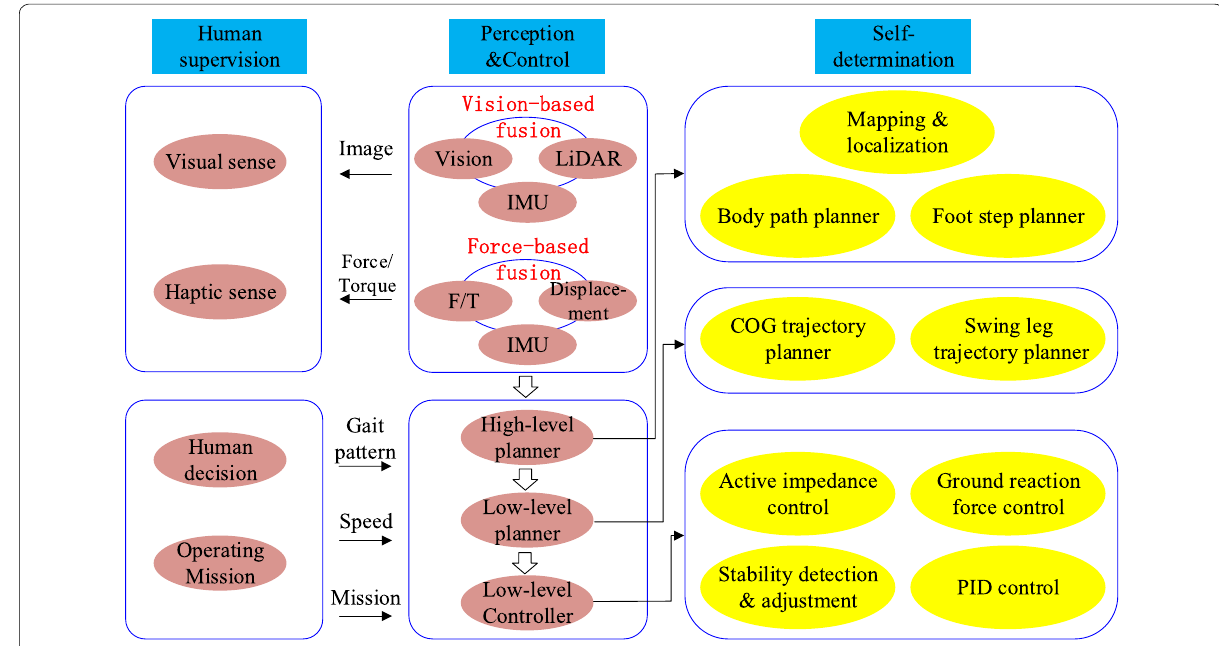
Figure 24 Combination of human supervision and robot’s self-determination